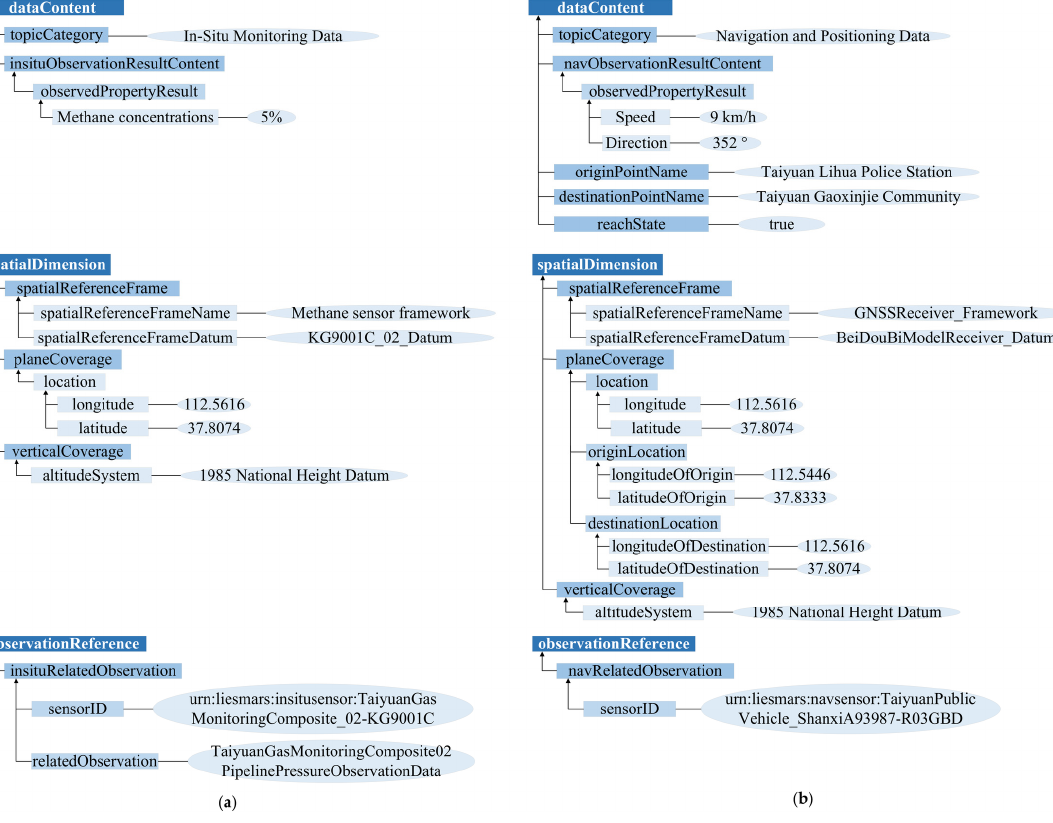
Figure 12. Comparison of the extended information description of different types of the DMM instances.